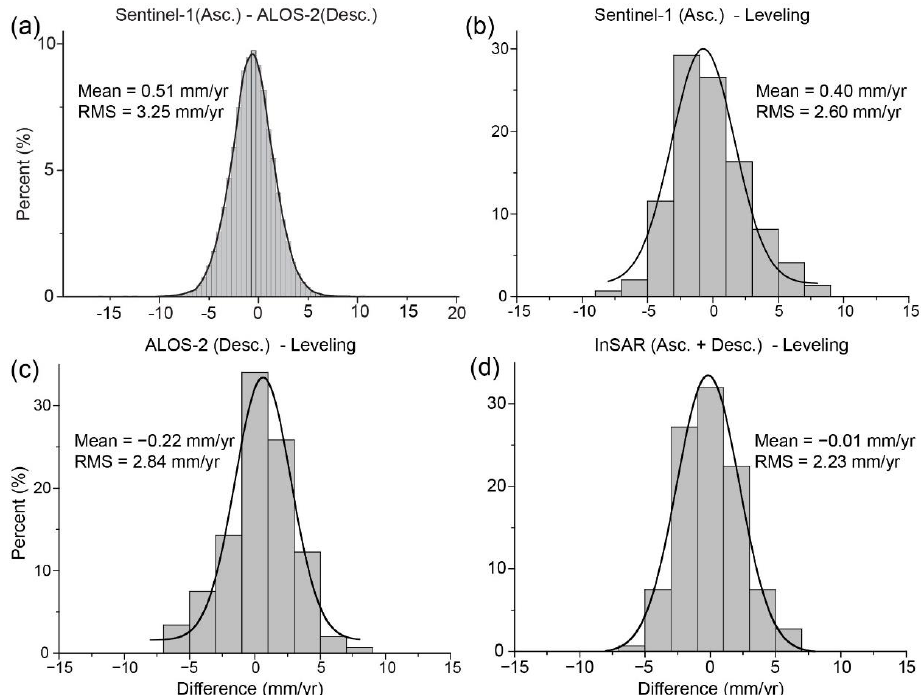
Figure 4. Histograms of the vertical deformation differences between the InSAR and leveling measurements: ( a ) ascending Sentinel-1A/B and descending ALOS-2; ( b ) Sentinel-1A/B and leveling data; ( c ) ALOS-2 and leveling data; and ( d ) MSBAS-derived vertical deformation and leveling data. Subsequently, the InSAR-generated vertical deformations were compared with lev- eling measurements along six profiles (brown lines in Figure 3). Figure 5 displays the ver- tical surface displacements along six profile sections with a 5 km buffer zone in the north – south direction throughout the Weihe Basin. The gray dots show the InSAR vertical de- formation, and the black lines represent the fitting lines of the InSAR observations utiliz- ing an FFT low-pass filter method. The leveling measurements (rectangles), major faults (grey lines), and the refined fault’s locations (red lines) , which are discussed in Section 6, are superimposed on the profile sections. The comparison results shown in Figures 4 and 5 indicate that the InSAR measurement is in great accordance with the leveling measure- ment, with an RMS of ~2.2 mm/yr, as shown in Figure 4d.